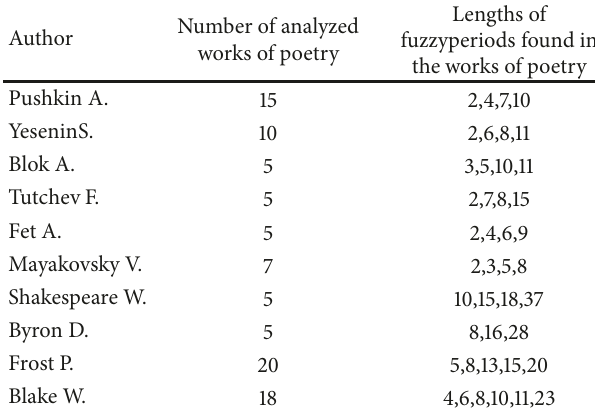
Table 1: Lengths of fuzzy periods found in 95 works of poetry of different